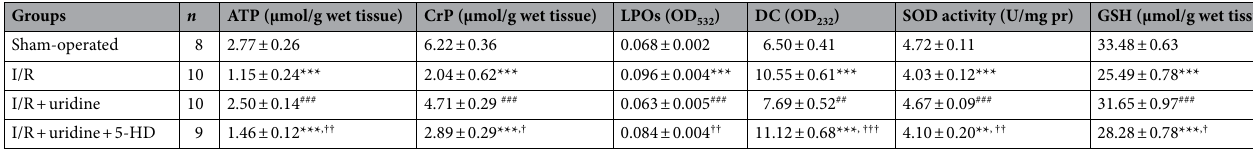
Table 3. Effect of uridine on ATP and CrP concentrations, lipid peroxidation and the antioxidant status in the rat myocardium after 120 min of reperfusion. I/R ischemia/reperfusion, 5-HD 5-hydroxydecanoate, CrP creatine phosphate, LPOs lipid hydroperoxides, DC diene conjugates, SOD superoxide dismutase, GSH reduced glutathione. All data are mean ± SEM ( n = 8–10). ** p < 0.01 versus sham-operated group; *** p < 0.001 versus sham-operated group; ## p < 0.01 versus I/R group, ### p < 0.001 versus I/R group; † p < 0.05 versus I/R + uridine group; †† p < 0.01 versus I/R + uridine group; ††† p < 0.001 versus I/R + uridine group. Significance of differences was determined by a one-way ANOVA followed by the Turkey’s multiple comparison Post Hoc